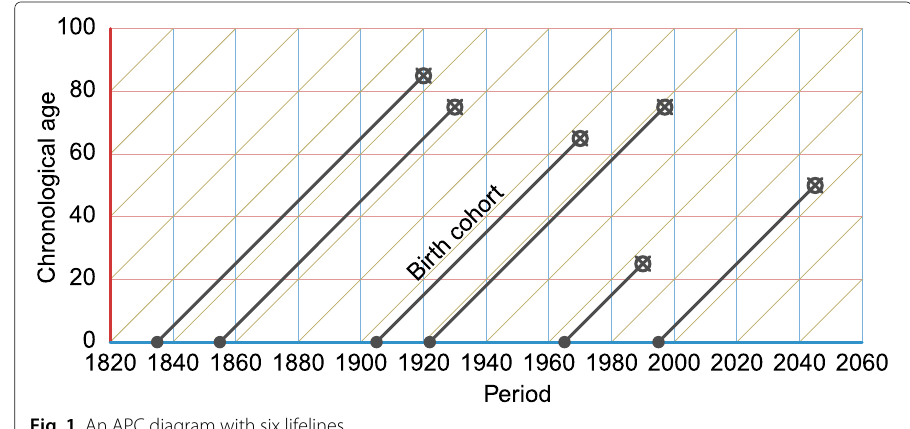
Fig. 1 An APC diagram with six lifelines